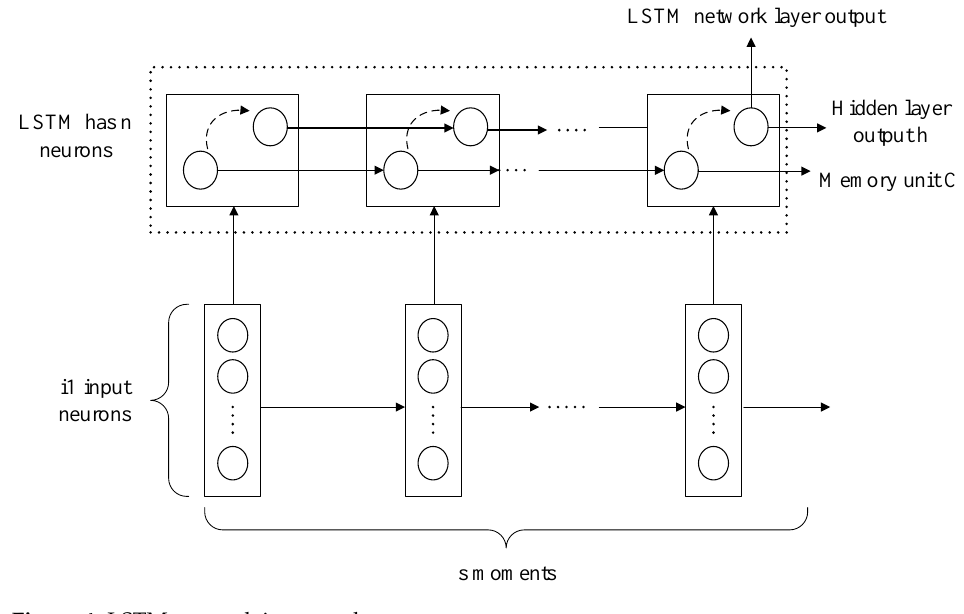
Figure 4. LSTM network input and output.